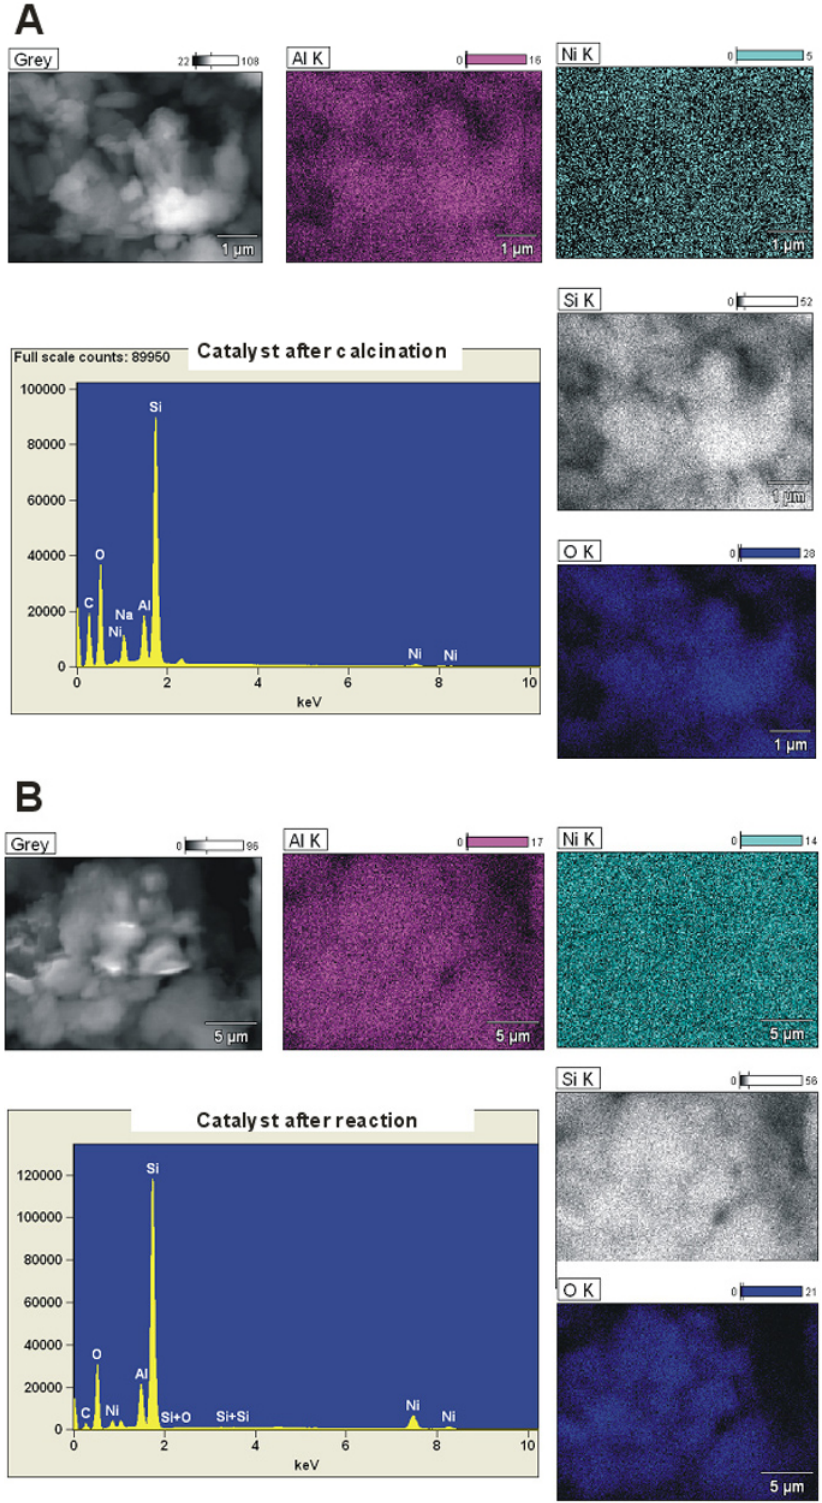
Figure 4. The results of SEM-EDS measurements for monometallic 5% Ni/Na-mordenite supported catalyst A) after calcination in air at 500°C for 4 h B) after